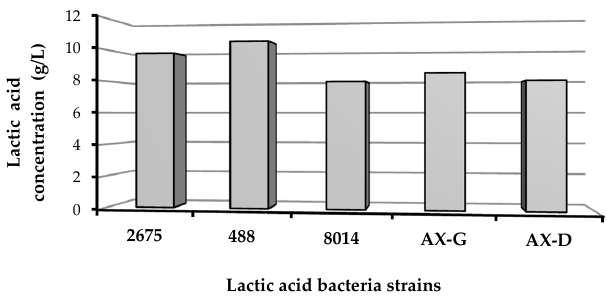
Figure 7. Lactic acid productivity of bacterial strains cultured on W1 hydrolysate.